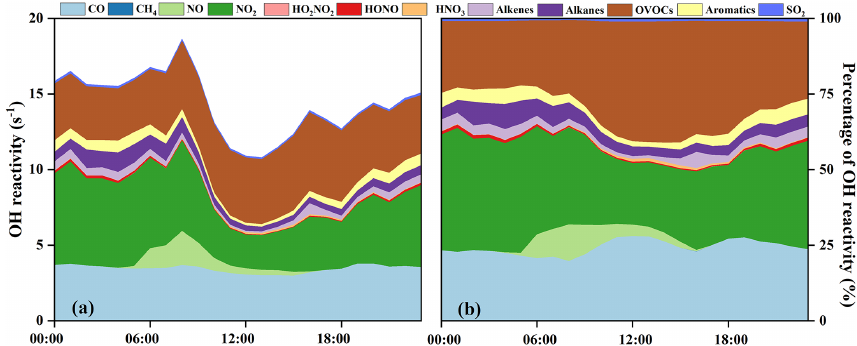
Figure 5. (a) Diurnal patterns and (b) percentage of model-calculated OH reactivity and its partitioning to the major